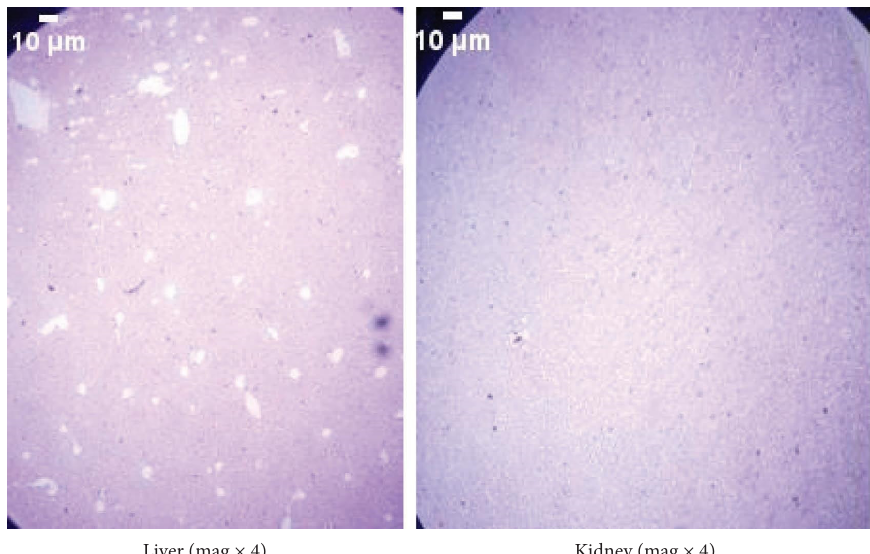
Figure 3: Histology of the liver and kidney of mice administered with C. martini essential oil at 1000mg/kg demonstrating the lack of abnormalities in the liver and kidney cells. (a) Liver (mag x4). (b) Kidney (mag